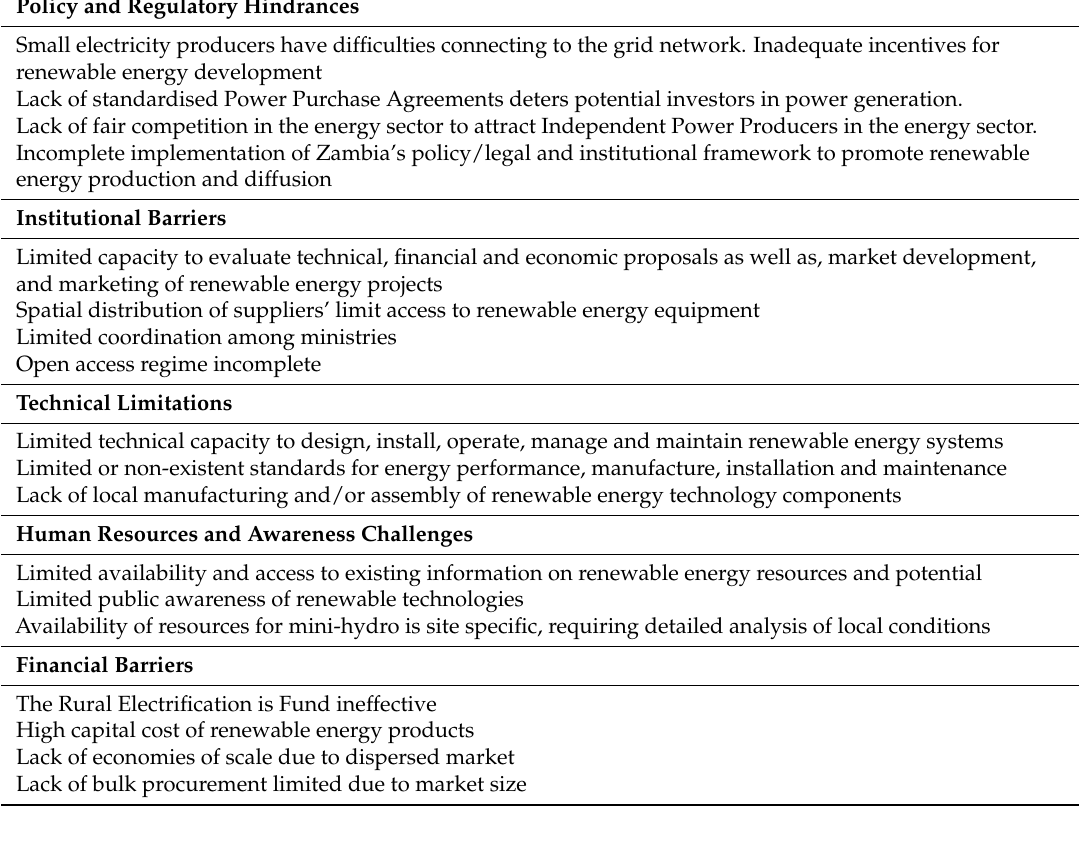
Table 4. Barriers to successful deployment of RETs in